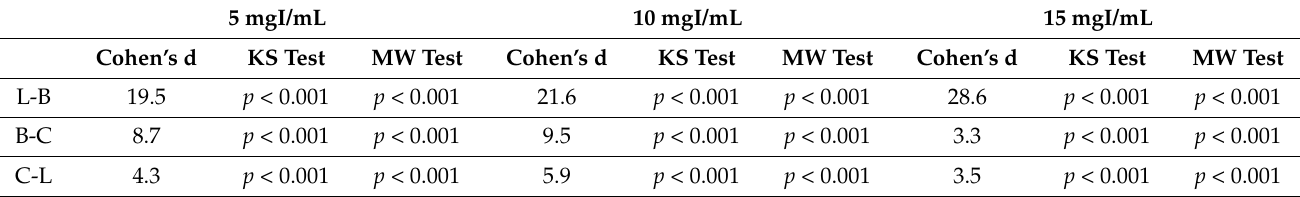
Table 2. Results from statistical analysis, including Cohen’s d, Kolmogorov–Smirnov and